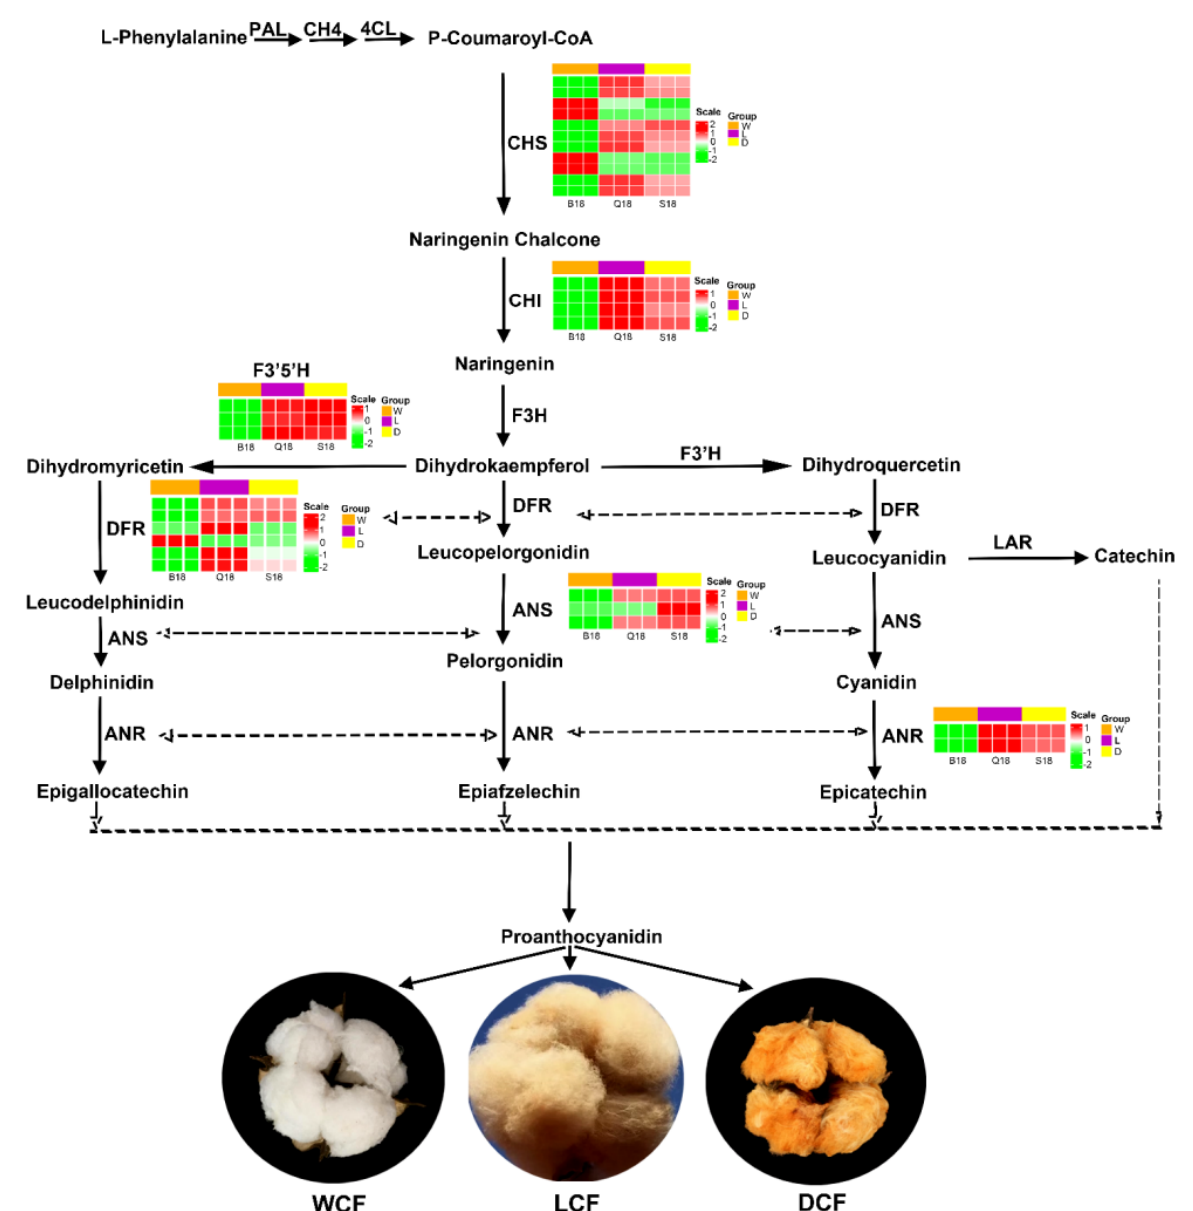
Figure 7. Schematic expression patterns of flavonoid-related genes at the different stages in WCF, LCF, and DCF. Enzyme abbreviations: PAL, phenylalanine ammonia lyase; C4H, cinnamate 4-hydroxylase; 4Cl, 4-coumarate: CoA ligase; CHS, chalcone synthase; CHI, chalcone isomerase; flavonoid 3 (cid:48) -hydroxylase; F3 (cid:48) 5 (cid:48) H; DFR, dihydroflavonol 4-reductase; F3H, flavone 3-hydroxylase; F3 (cid:48) H, LAR, leucoanthocyanidin reductase; ANS, anthocyanidin synthase; ANR, anthocyanidin reductase; Heatmaps were created according to the average expression levels based on FPKM value. A color bar is presented on the right.